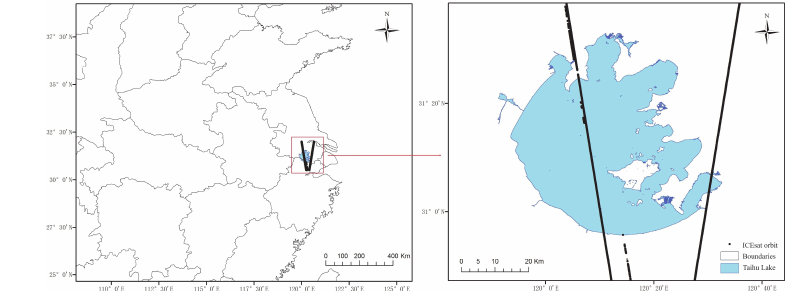
Figure 1. The location of Taihu